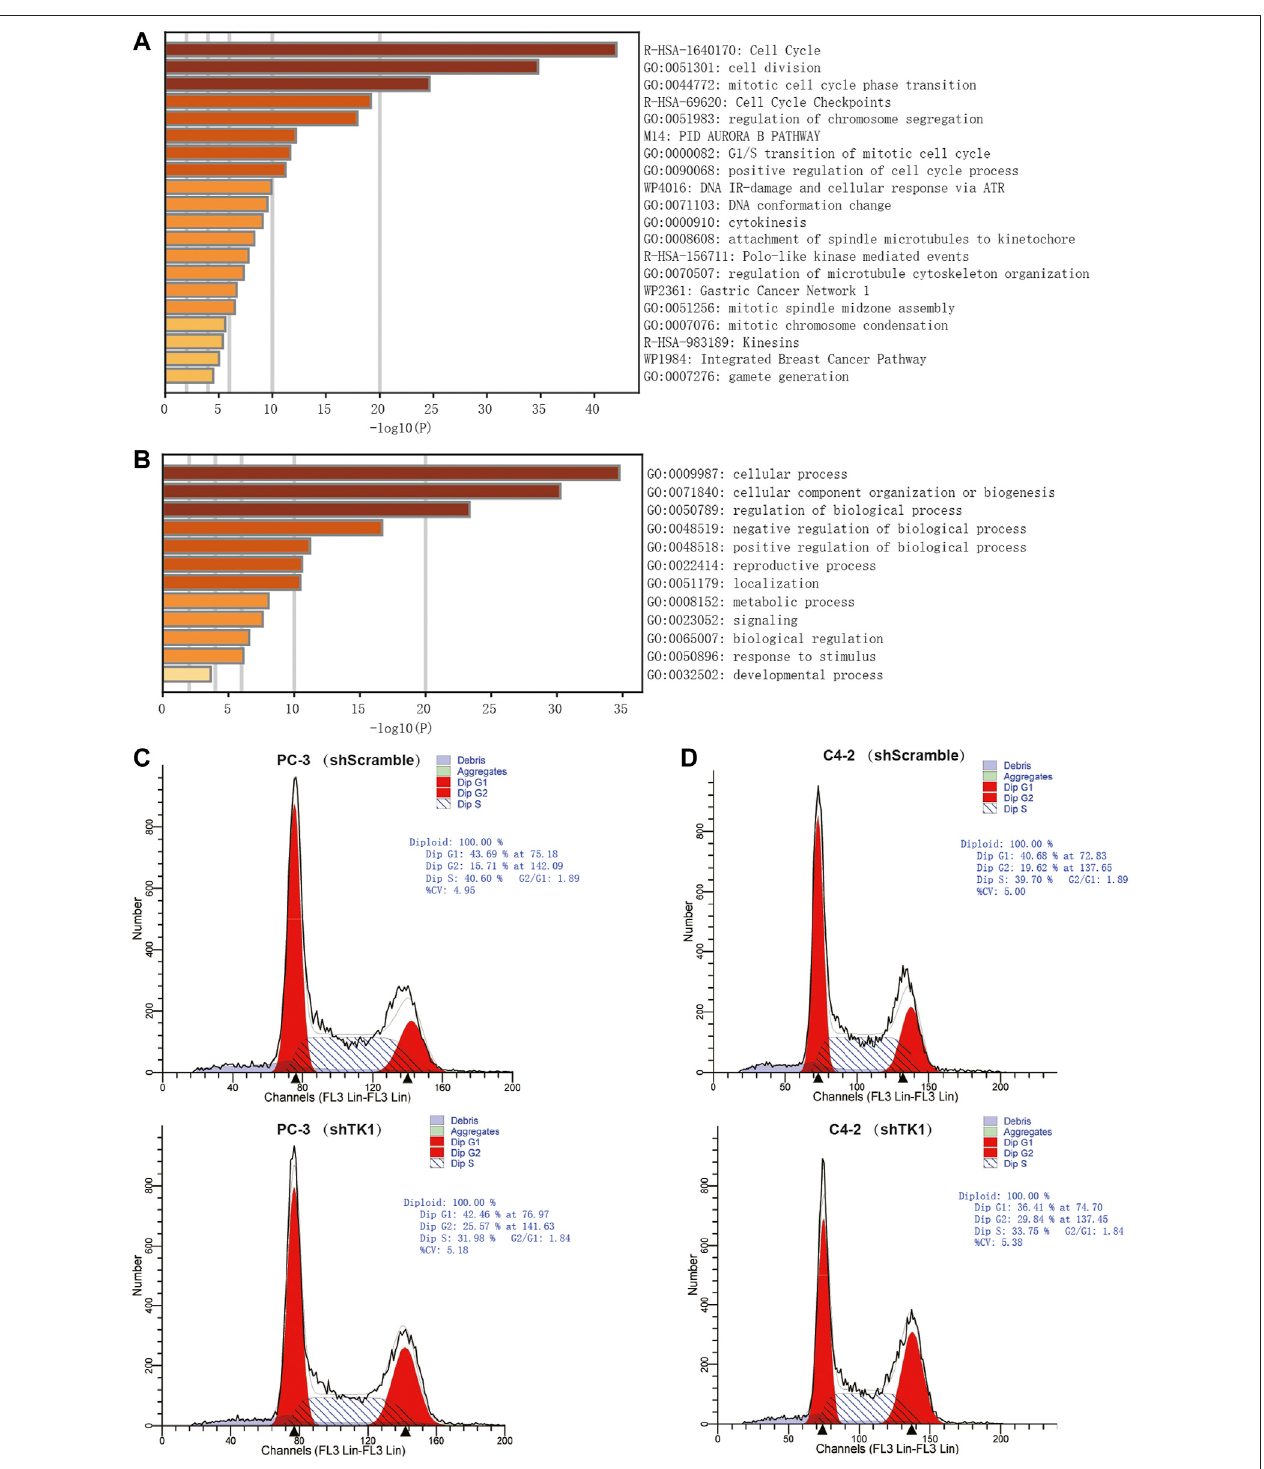
FIGURE 3 | Enrichment analysis and veri fi cation of the co-expressed genes. (A,B) Bar graph of enriched pathways (A) and top-level Gene-Ontology biological processes (B) crosstheco-expressedgenes. (C,D) TK1silencingincreases thepercentage ofcellsintheG2/Mphase. Cellcycledistributions wereinvestigated by fl ow